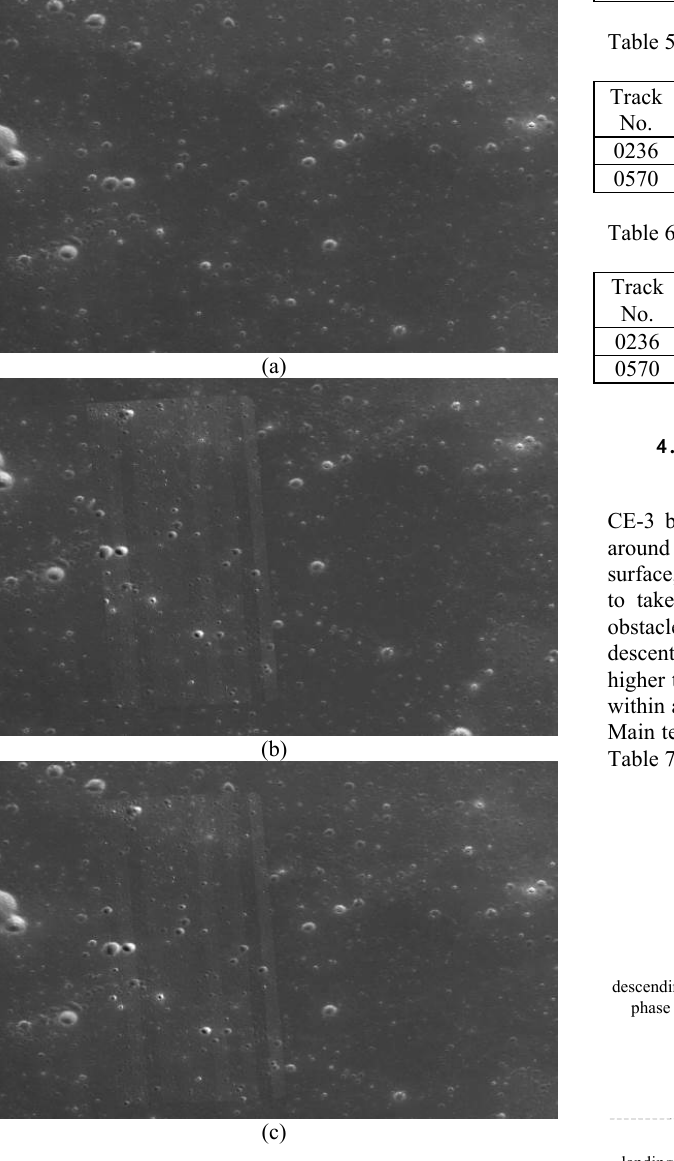
Figure 3. Overlaid CE-2 DOMs. (a) Base DOM from No.0570 track (7m-resolution), (b) Overlaid DOMs from No.0236 (1.5m- resolution) and No.0570 track before adjustment, (c) Overlaid DOMs after adjustment Table 3.Calibration parameters for CE-2 CCD images